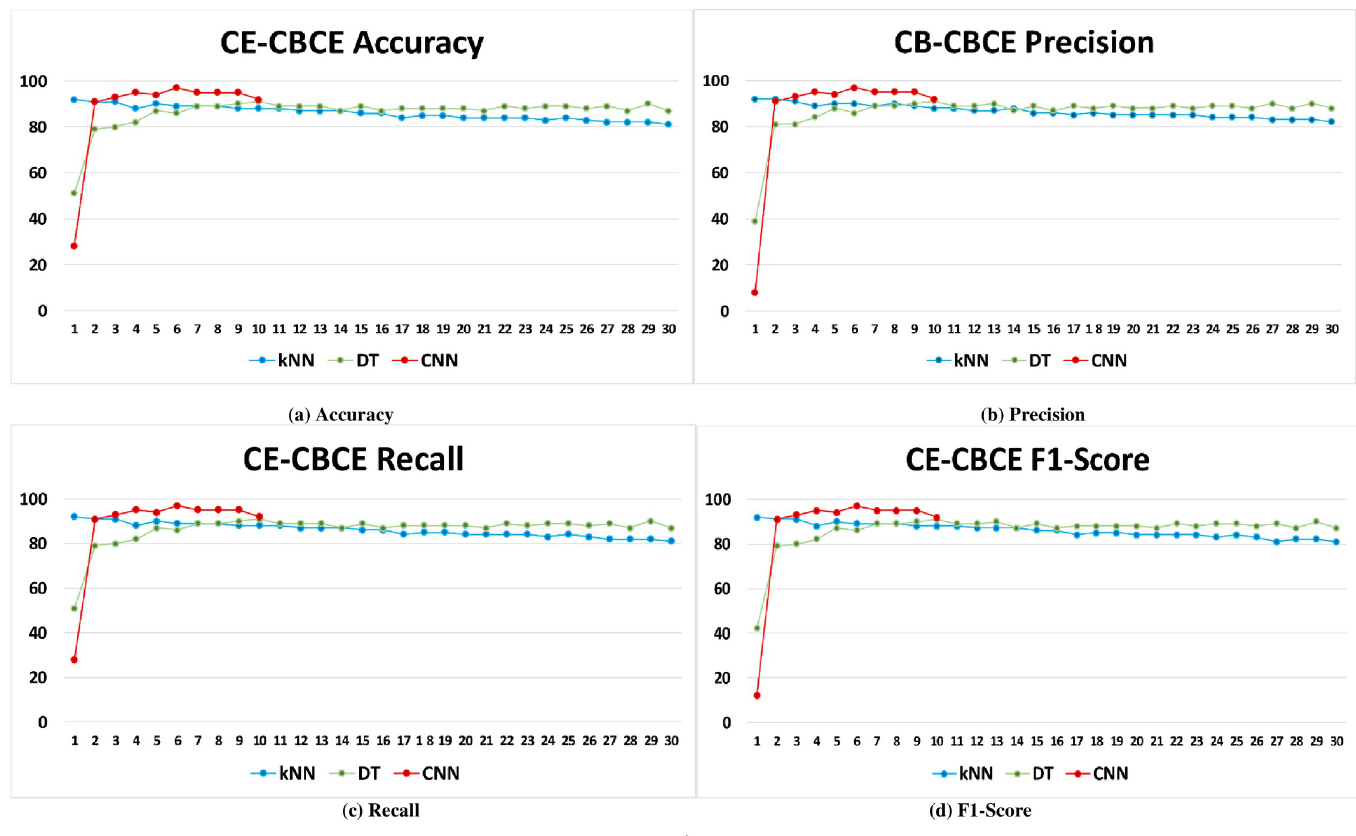
Fig 7. Full results of the proposed extraction CE-CBCE method across all optimization techniques. https://doi.org/10.1371/journal.pone.0256665.g007 samples for each orientation. Table 6 shows the best results obtained from each feature extrac- tion methods. In the Table 6, excellent results for the object’s orientation are recorded. The combination of CE-CBCE method achieved accuracy of 82%, followed by CE, CBCE, MFE, ROI and finally FV methods. Especially for easily perceived poses for human subjects facing right or left, CE-CBCE and CE methods both recorded 100% detection rate. The radar chart in Fig 8 shows the accuracy of CE + CBCE method for each object with varying pose orientation.